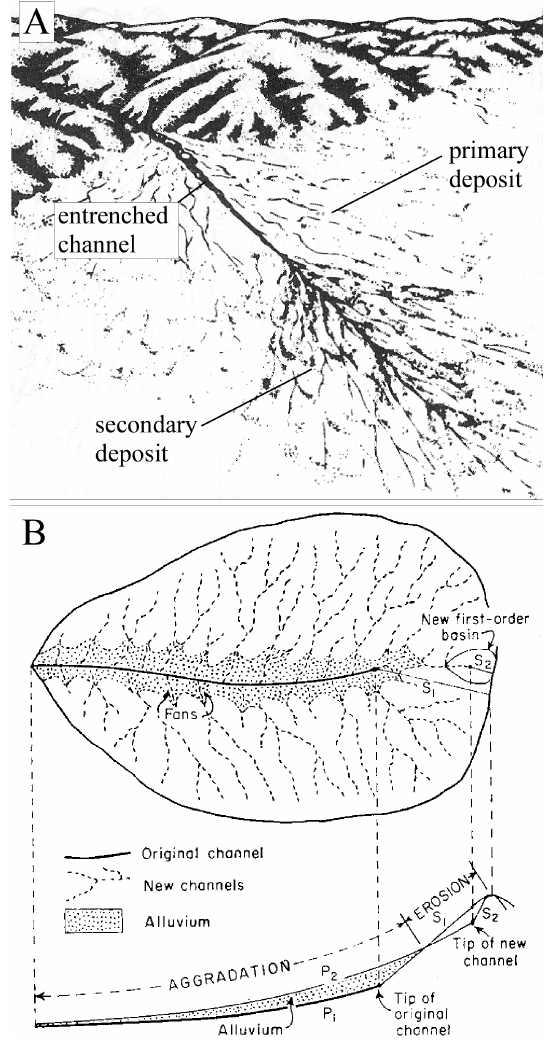
Figure 2. Schematic diagrams drawn from the literature illustrating (a) fan and (b) source-catchment responses to semiarid-to-arid tran- sitions. (a) Illustration of paired deposits (i.e., a secondary deposit downstream and inset into a primary deposit) resulting from a sin- gle pulse of sediment (from Bull, 1968). In (a) , a pulse of sediment from upstream catchments leads to a “primary” phase of aggrada- tion. When sediment supply declines during the waning phase of the sediment pulse, fluvial channels incise into the sediments just deposited and an abandoned fan terrace is formed. Sediments re- worked by channel incision, along with sediments still being sup- plied by the catchment in the waning phase of the sediment pulse, are then deposited in a “secondary” deposit farther downslope. (b) Schematic diagram illustrating the response of a catchment to an in- crease in erosivity (from Strahler, 1968). Low-order drainages grow headward, converting hillslopes, and into low-order fluvial channels capable of rapidly transporting material stored as colluvium during the previous period. When channels cease growing headward (i.e., when the catchment stabilizes to a new, higher drainage density), the pulse of sediment wanes and channel incision/secondary aggra- dation is triggered (not